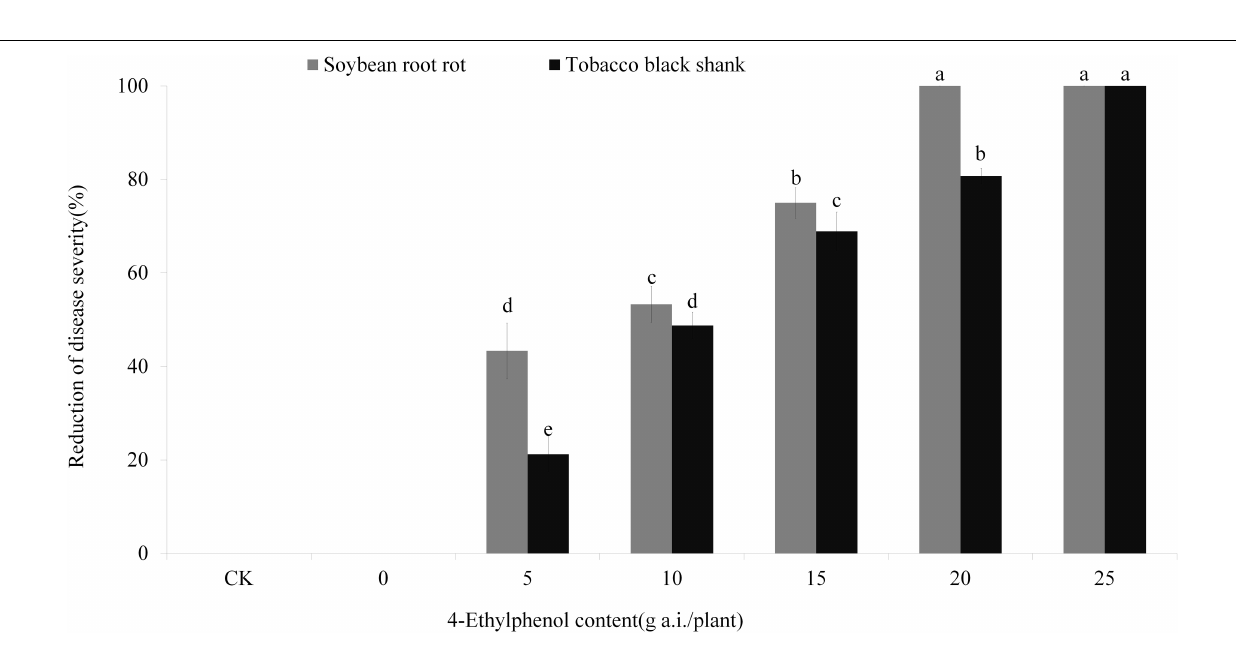
Frontiers in Plant Science |